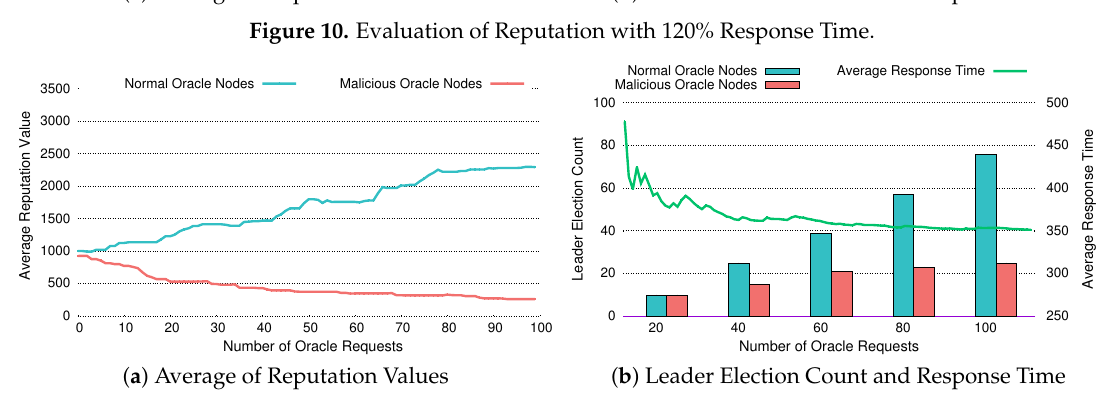
Figure 11. Evaluation of Reputation with 150% Response Time.